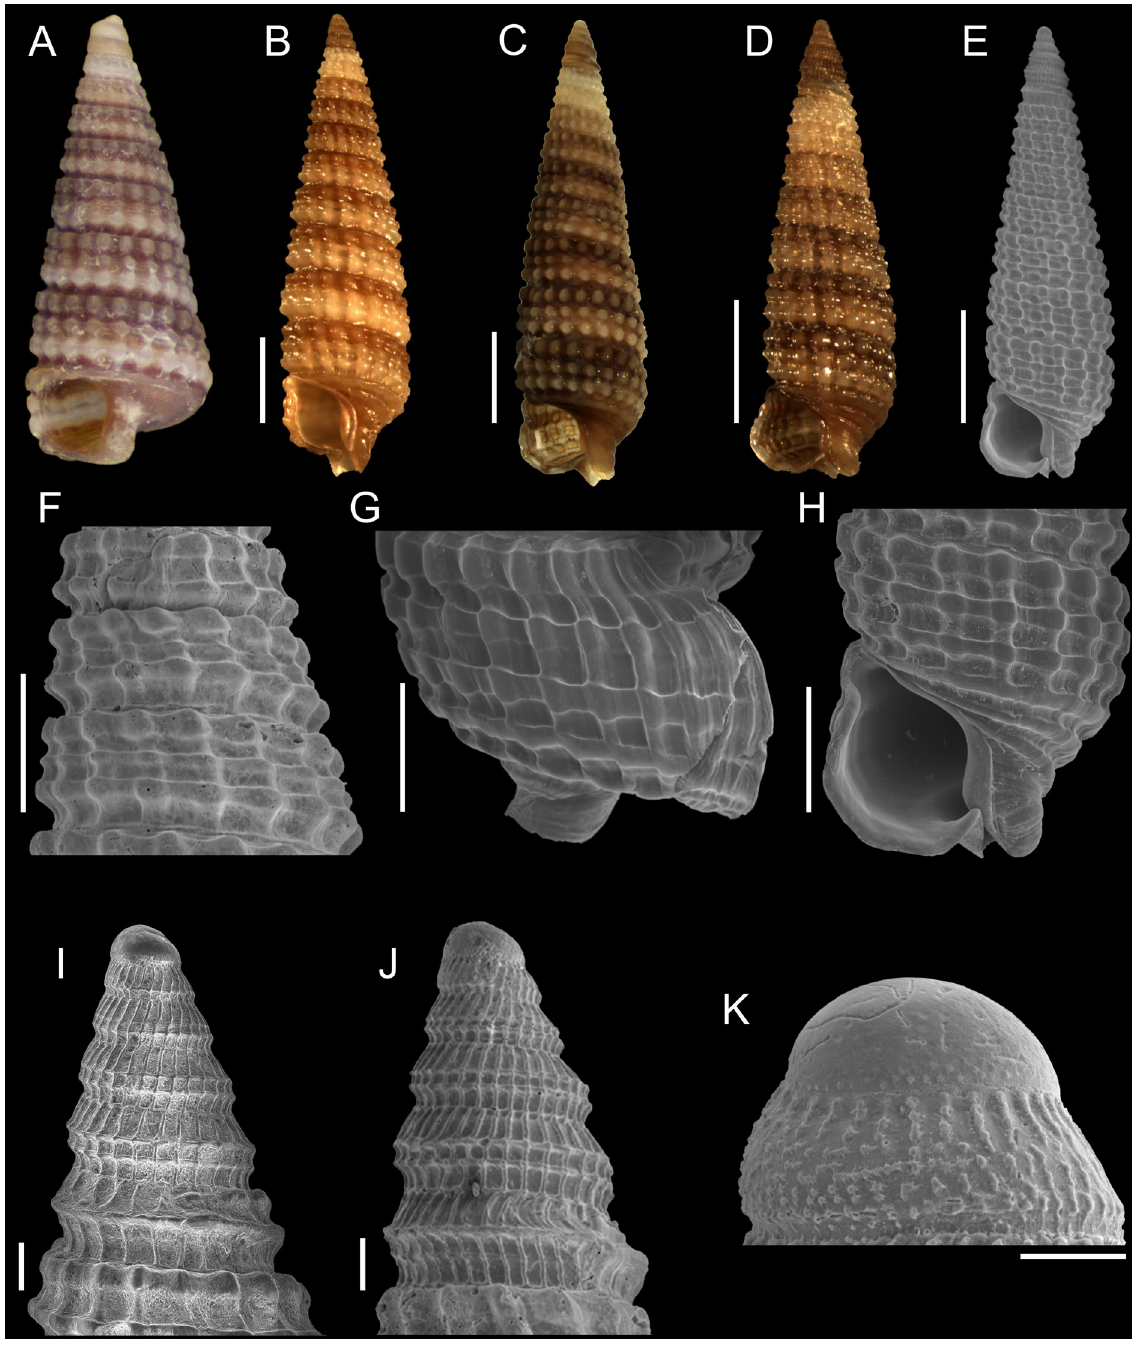
Fig. 94. Similiphora intermedia (C.B. Adams, 1850). A . Lectotype, MCZ 186161. B . MNRJ 17967*, 5.42 mm. C . MNRJ 29763*, 5.12 mm. D . MNRJ 18953*, 3.73 mm. E, H . Same shell as D. F, J . MNRJ 17976*. G, K . Same shell as C. I . MNRJ 34027*. Scale bars: A–E = 1 mm; F–H = 500 µm; I–J = 100 µm; K = 50 µm